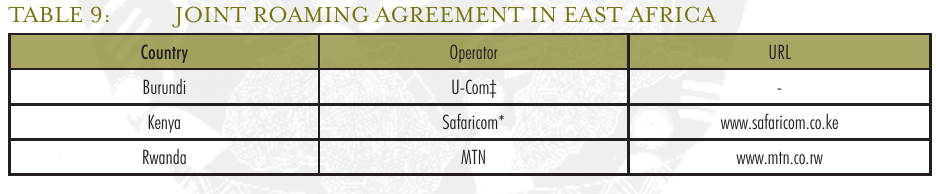
JOINT ROAMING AGREEMENT IN EAST AFRICA Country